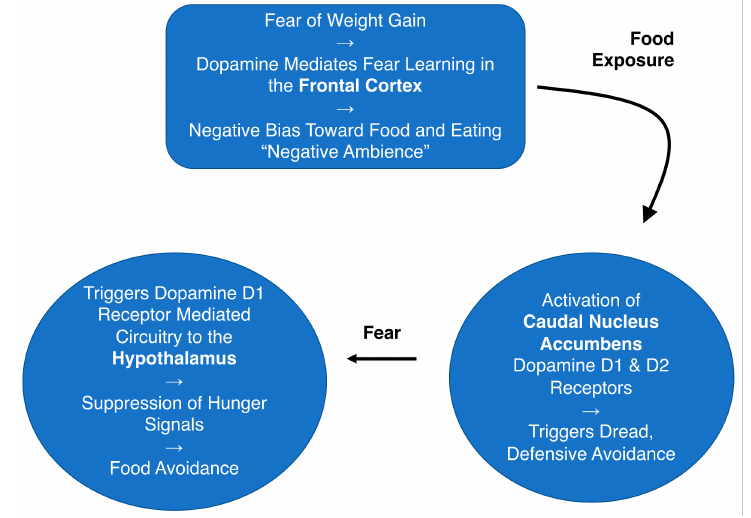
Figure 1. Hypothesized model for food avoidance in anorexia nervosa based on Castro et al., 2015